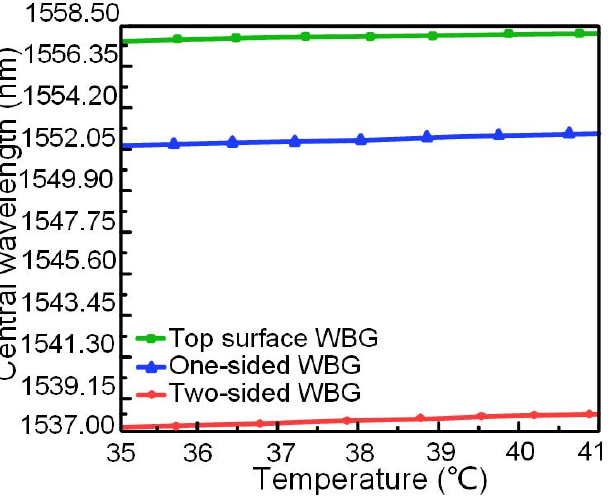
Figure 4. Change of WBG center wavelength with temperature in three structures. Through the control variable method, the performance parameters of the top-surface, one-sided, and two-sided WBG structures were compared by etching depth and width, duty cycle, and number of cycles. The two-sided WBG, which consisted of 100 notches that were 0.22- µ m deep and 0.51- µ m wide, with a 0.5-duty cycle, had the best performance, with a temperature sensitivity of 92 pm/ ◦